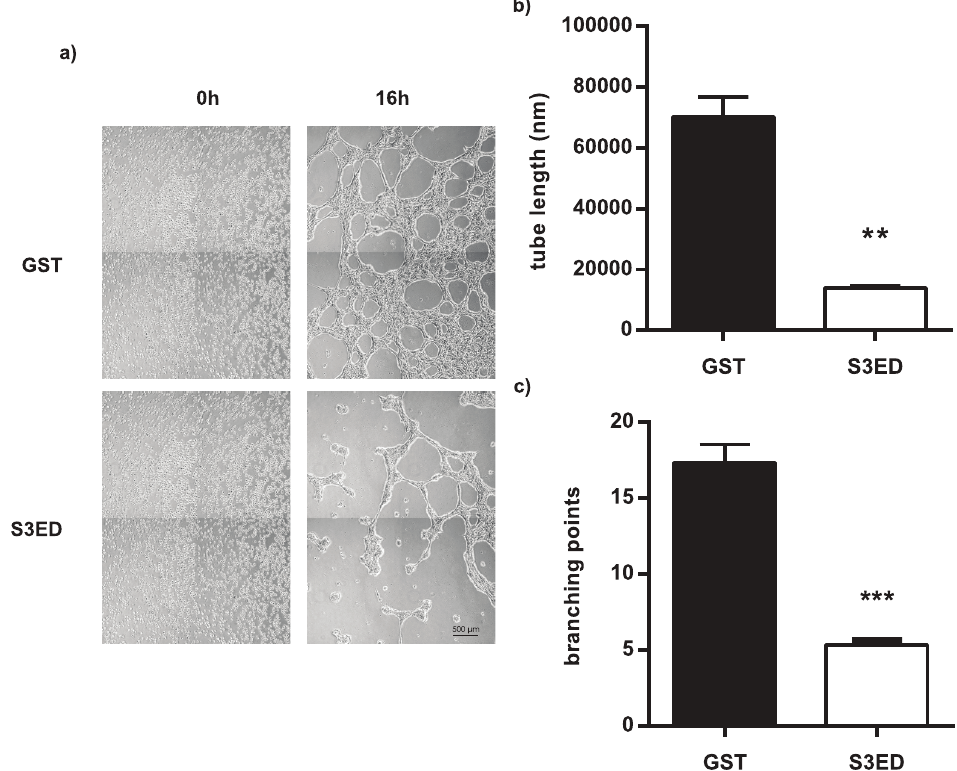
Figure 4. S3ED inhibits EC network formation in response to Matrigel. bEND3.1 cells were seeded on Matrigel in media containing GST or S3ED (0.5 µM) and micrographs were obtained after 16 hours ( a ). Tube length ( b ) and branch points ( c ) were calculated and both were reduced in the presence of S3ED. Error bar represents SEM. T-test was used to compare S3ED to GST